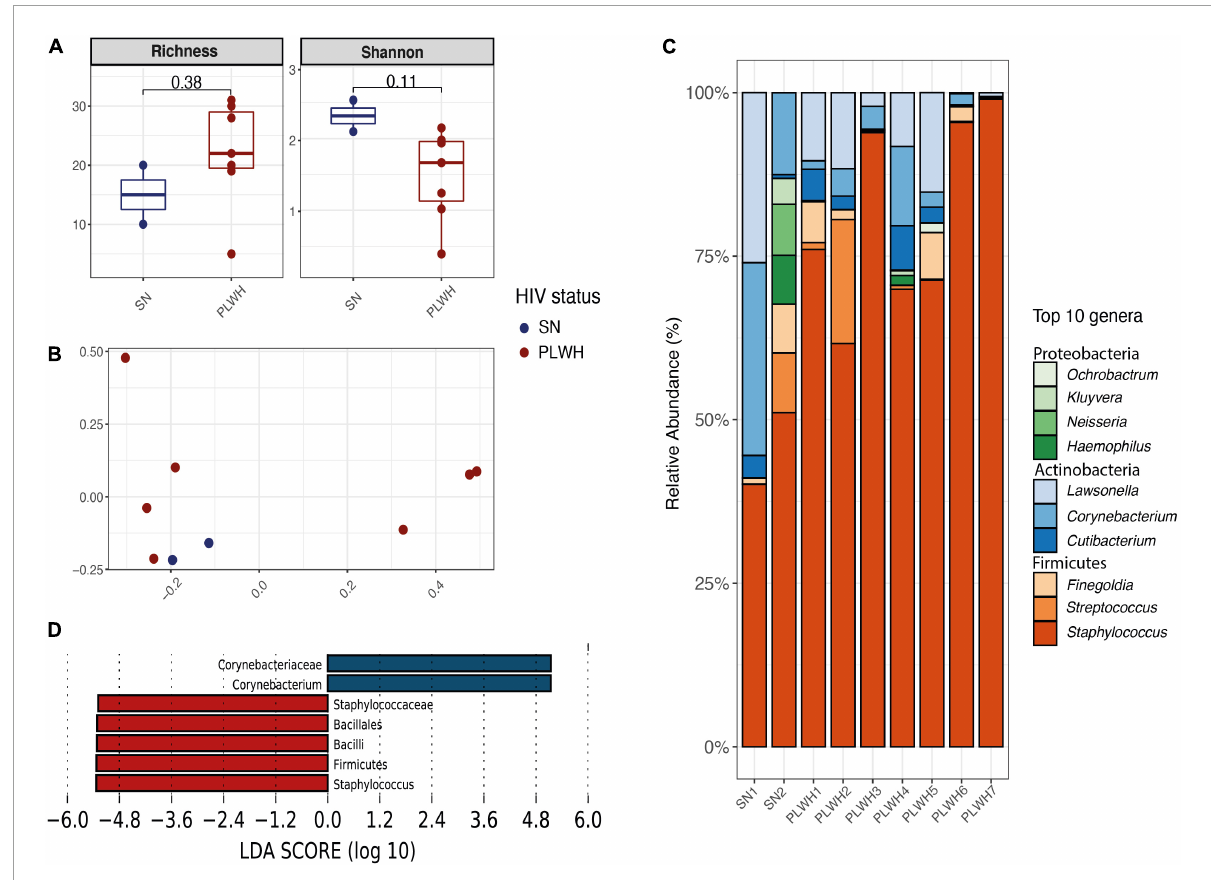
FIGURE4 Diversity and bacterial communities of the nasopharynx of PLWH and SN. (A) Boxplots showing the median and interquartile range. Two alpha diversity metrics were estimated: richness (number of observed species) and shannon. Groups were compared using the Wilcoxon Rank Sum test. There were no differences between PLWH and SN. (B) Principal coordinate analysis of Bray-Curtis dissimilarity, constructed from the ASV table. Samples were clustered according to their HIV status. Samples did not cluster by HIV status (PERMANOVA p = 0.407). (C) Taxa barplots showing the taxonomic composition at genus level. Only the top 10 genera are represented, these account for 99.5% of all genera present. Genera are listed from the less abundant to the more abundant within each phylum, and ordered in ascending order (Proteobacteria, Actinobacteria, and Firmicutes). Color bars reflect the phyla they belong to and the intensity of the color their relative abundance, with light colors depicting the least abundant, and the darker colors the more abundant. (D) Histogram of the LDA scores revealed two differential features taxa by HIV status: Corynebacterium was found enriched in SN while Staphylococcus enriched in PLWH. LEfSe analyses were performed with LDA values of 4.0 or higher. HIV, human immunodeficiency virus; LDA, linear discriminant analysis; LEfSe, linear discriminant analysis effect size; PCoA, principal coordinate analysis; PERMANOVA, permutational multivariate analysis of variance; PLWH, people living with HIV; and SN,